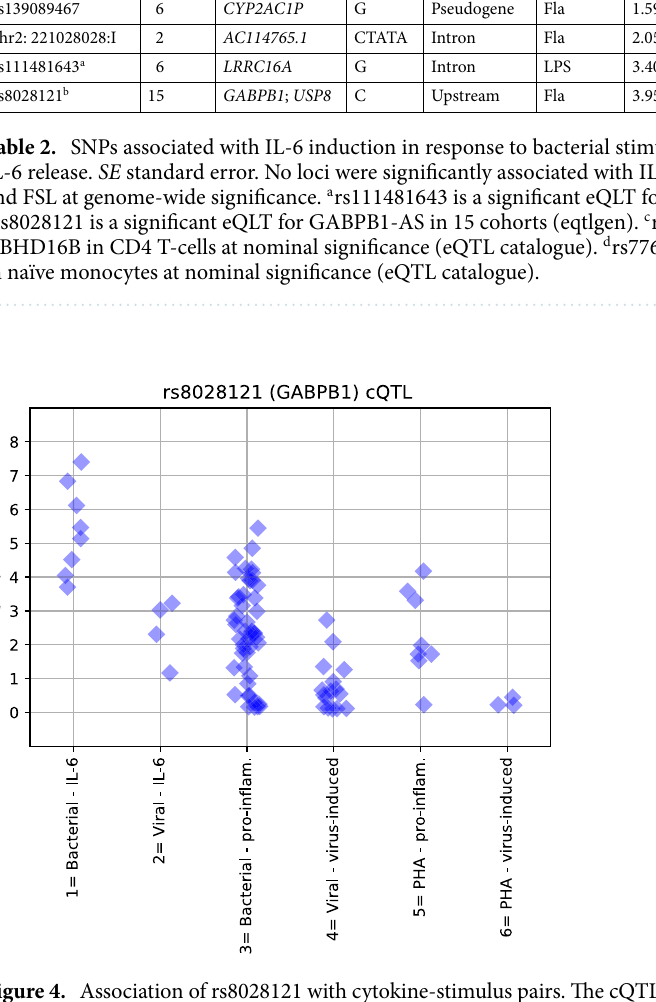
the transcription factor nuclear respiratory factor 2 (NRF2) which regulates expression of antioxidant proteins that protect against oxidative damage triggered by infections 16 . We replicated previously reported associations between the SNPs rs351250 and rs683458 1 and IL-6 responses to pathogens 12 . We report associations between